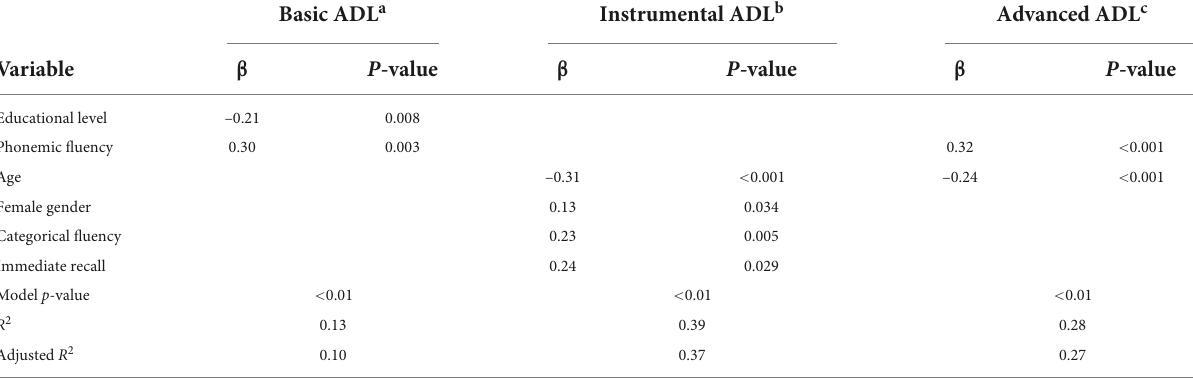
TABLE 3 Regression models with predictors for ADL self-report scales